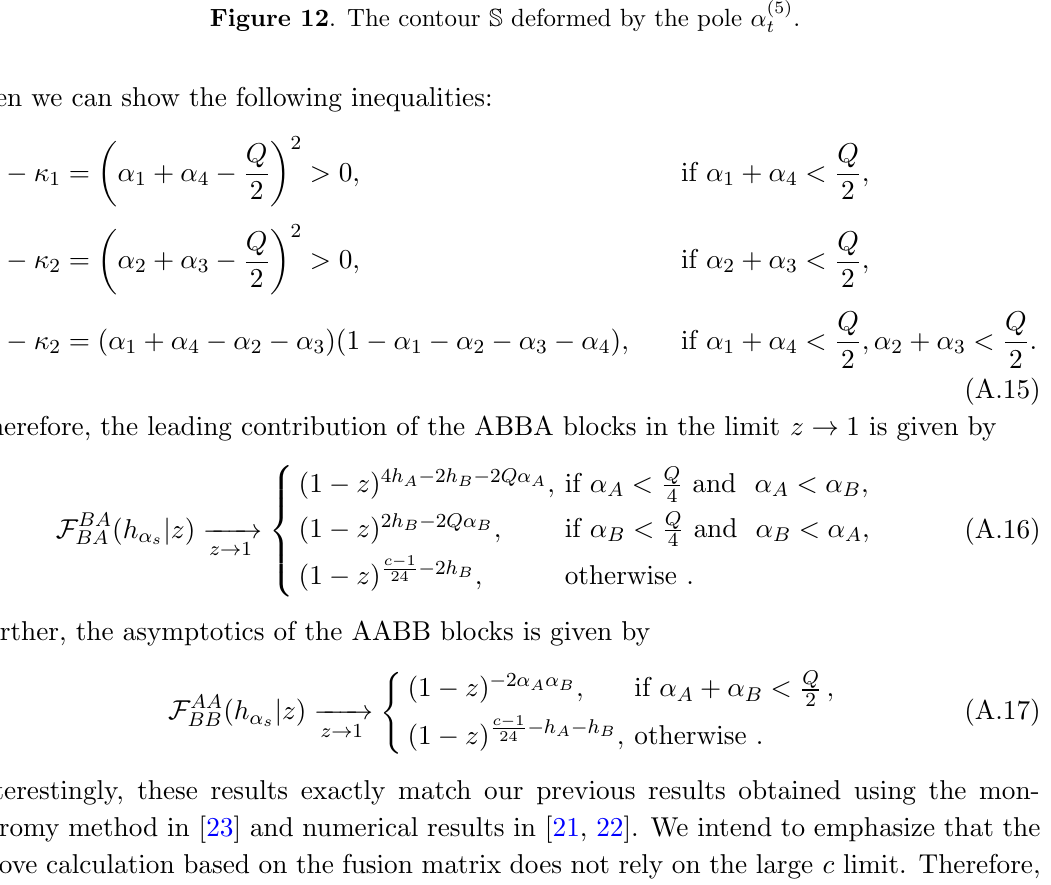
Figure 12 . The contour S deformed by the pole (cid:11) (5)